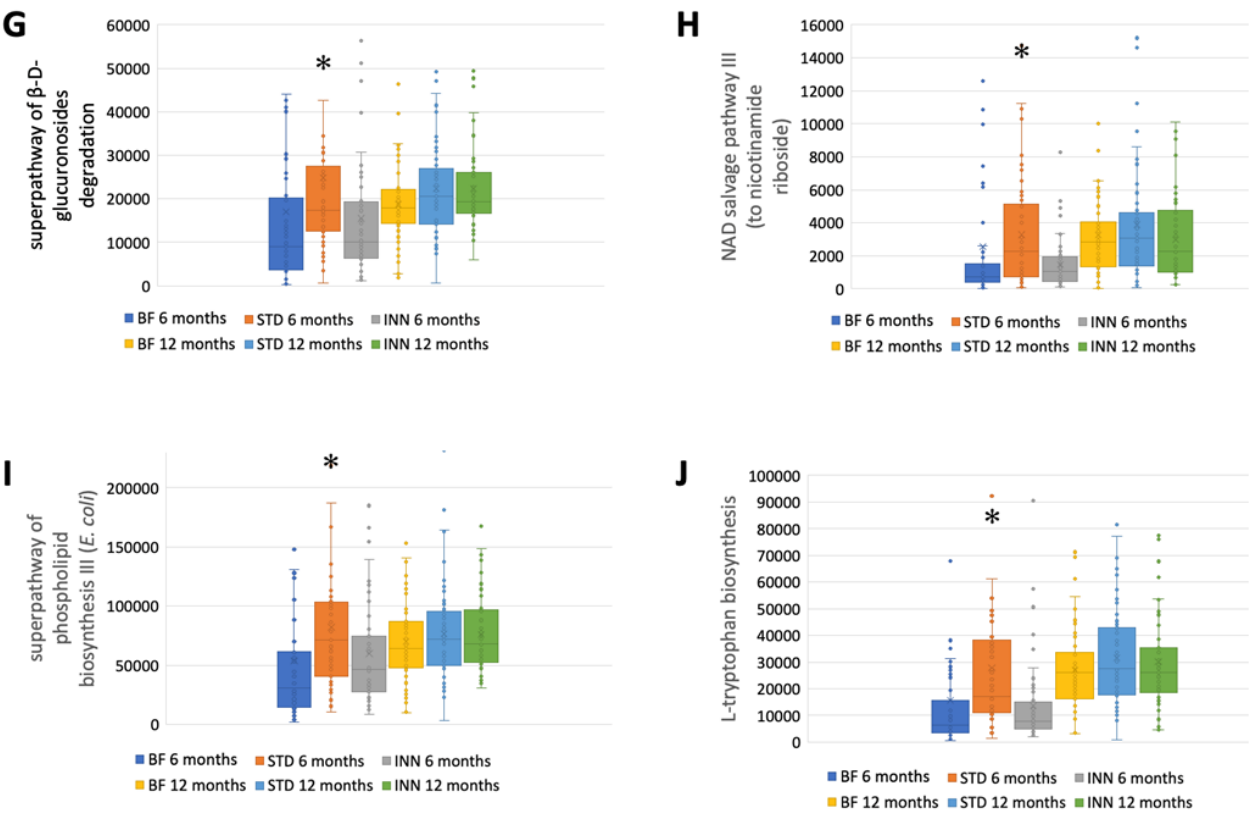
Figure 3. Major metabolic pathways. ( A ) Glycolysis. ( B ) Superpathway of hexuronide and hexuronate degradation. ( C ) D-galactarate degradation I. ( D ) D-galacturonate degradation I. ( E ) D-glucarate degradation I. ( F ) Superpathway of D-glucarate and D-galactarate degradation. ( G ) Superpathway of β-D-glucuronosides degradation. ( H ) NAD salvage pathway III (to nicotinamide riboside. ( I ) Superpathway of phospholipid biosynthesis ( E. coli ). ( J ) L-Tryptophan biosynthesis. * p < 0.05, significant differences were calculated with independent sample median test adjusted by the Bonferroni correction for multiple tests vs. BF group. † p < 0.05, BF group, 6 months vs. 12 months. ‡ p < 0.05, INN group, 6 months vs. 12 months.